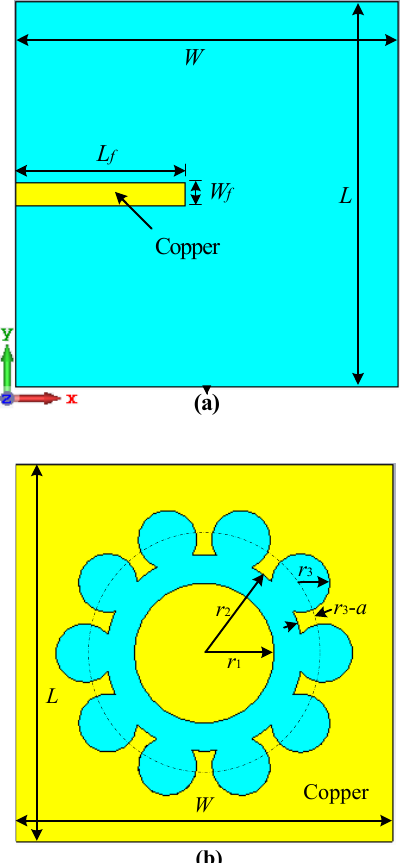
Figure 1: Structure of the proposed slot antenna: (a) upper layer, (b) bottom